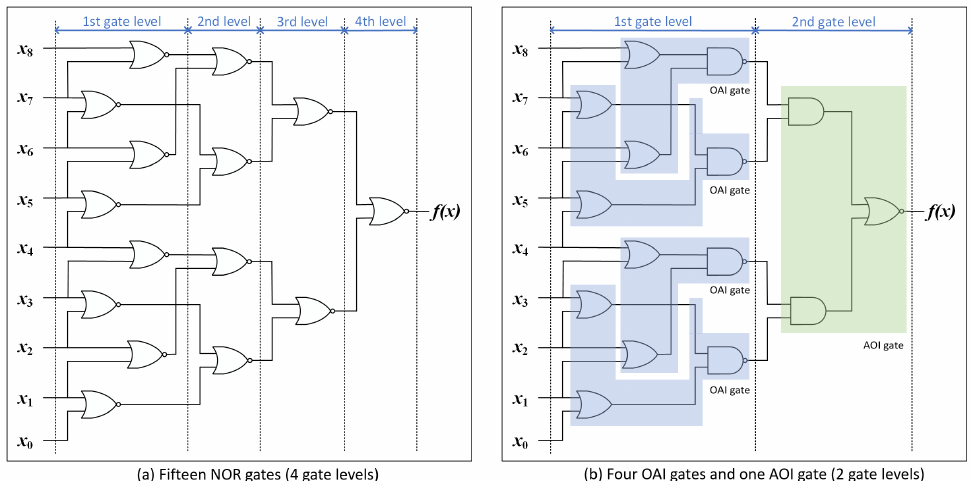
Figure 7. A low-latency implementation of F 1